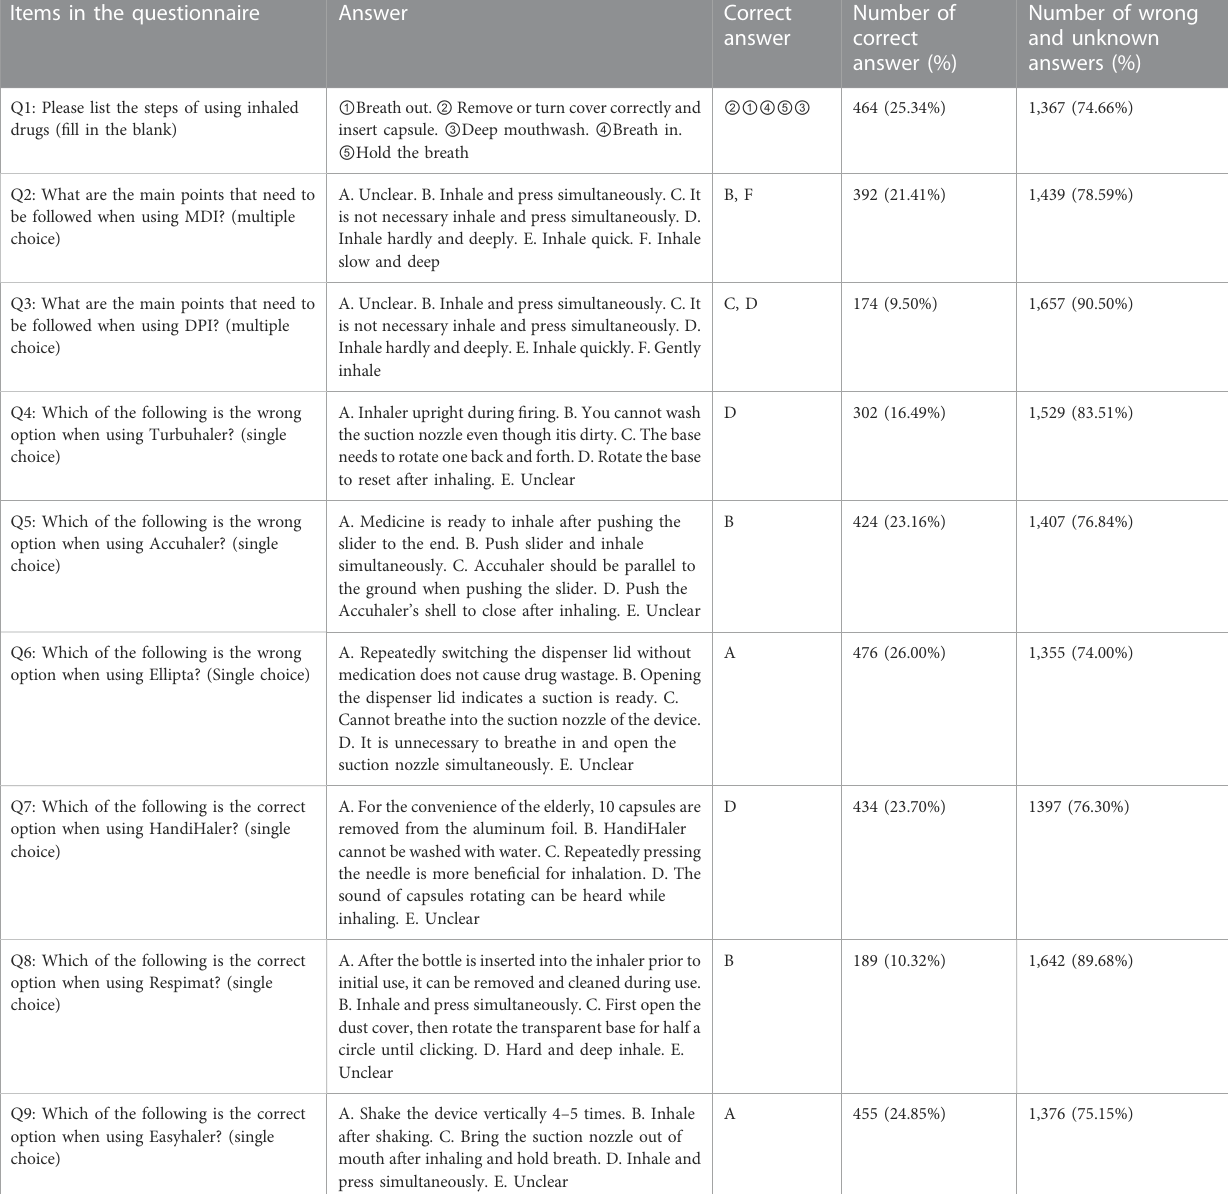
TABLE 2 Overview of the questions about knowledge of inhaler use. Items in the